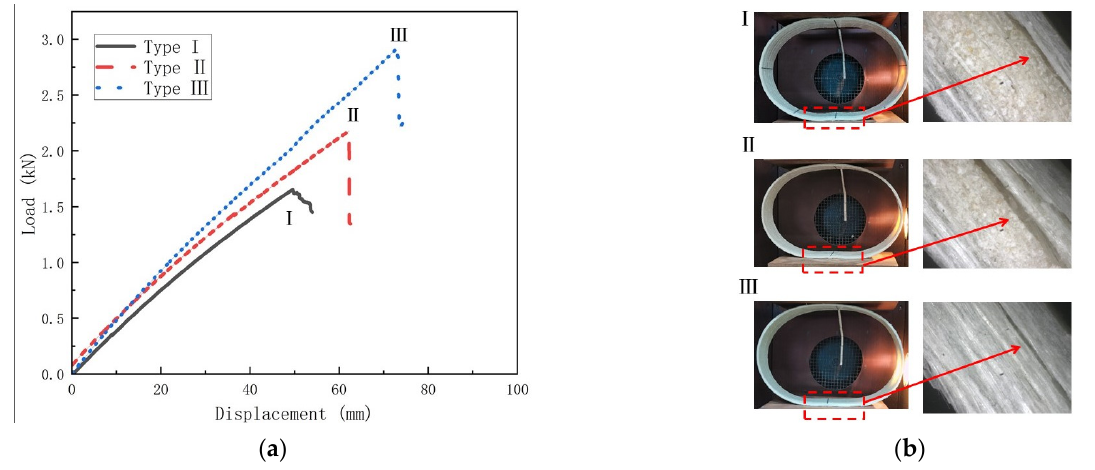
Figure 14. Load–displacement curves and failure mode diagrams for different types of GFRP pipes at 50 °C ( a ) Load–displacement curve for GFRP pipes; ( b ) Failure mode.